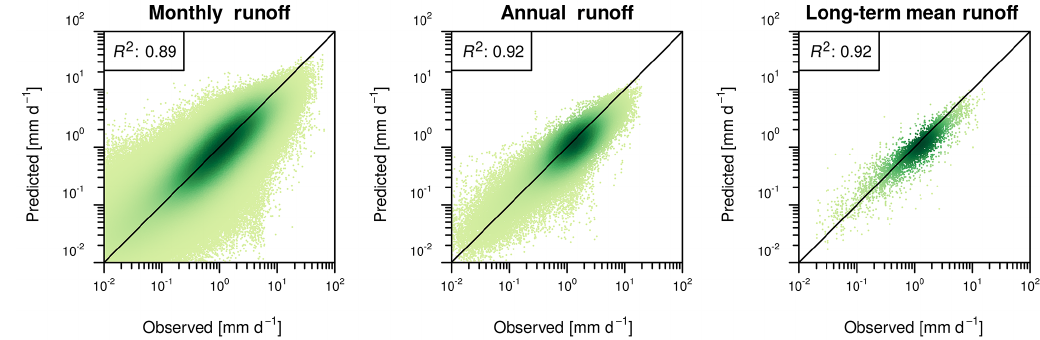
Figure 3. Scatterplots of observed versus predicted runoff values. The colour intensity is related to the point density.